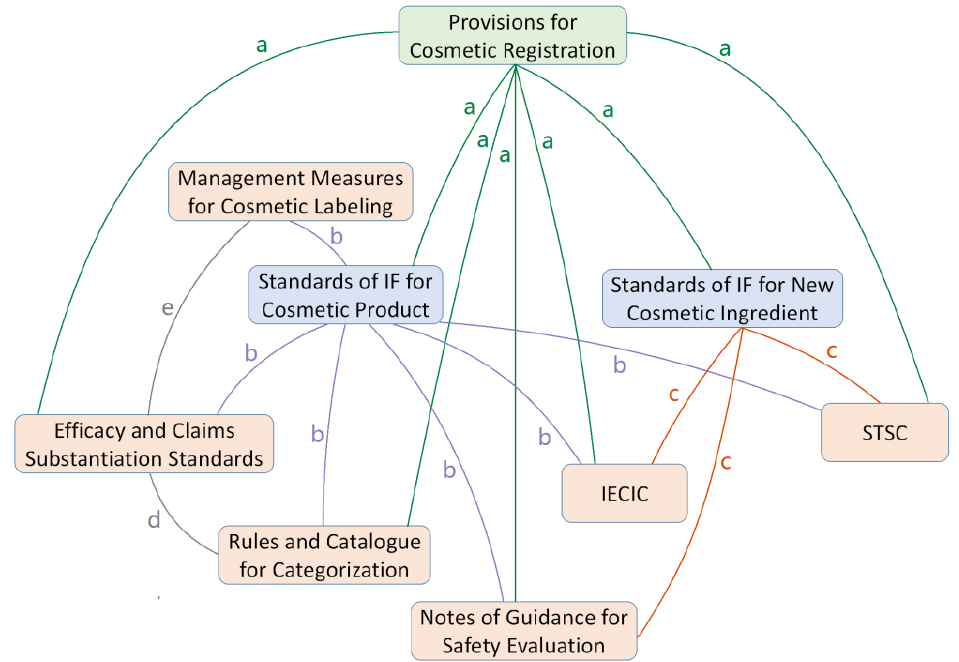
Figure 2. Major regulations involved in the technical evaluation of cosmetics. In this figure, regulations directly or strongly related to the technical evaluation work of cosmetic products and new ingredients are included, and the curves indicate the relevance of the regulations: (a) these regulations are based on and under the system of the “Provisions for Cosmetic Registration”; (b) the “Standards of IF for Cosmetic Product” is the core regulation in product submission, and technical regulations are cited in the standards as basis or reference; (c) the “Standards of IF for New Cosmetic Ingredient” is the core regulation in new ingredient submission, and technical regulations are cited in the standards as basis or reference. In addition, it contributes to the ingredient management system together with IECIC and STSC; (d) the “Efficacy and Claims Substantiation Standards” and “Rules and Catalog for Categorization” share a unified logic and principle of efficacy category; (e) labeling information of cosmetic products should be based on efficacy and claim substantiation.